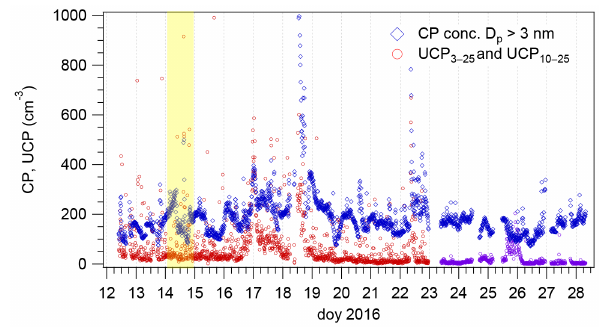
Figure 6. CP (blue diamonds), UCP 3–25 (red circles), and UCP 10–25 (purple circles) concentration time series (10min resolu- tion) during the campaign 2016. The period of the LPS16 is shaded in yellow.